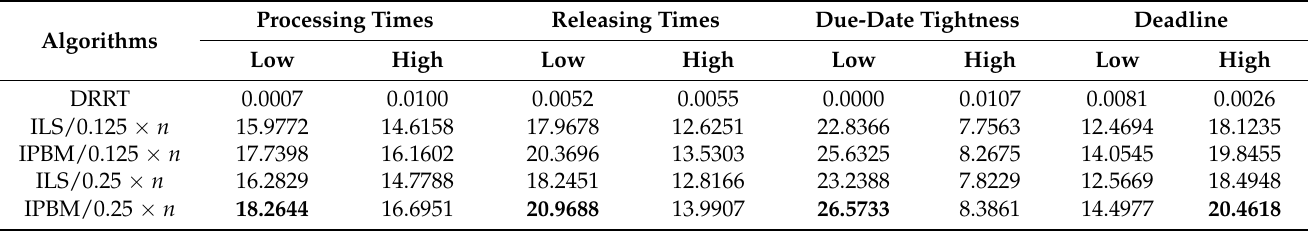
Table 5. Results for different processing times, releasing times, due-date tightness, and deadline (in RPD). Algorithms